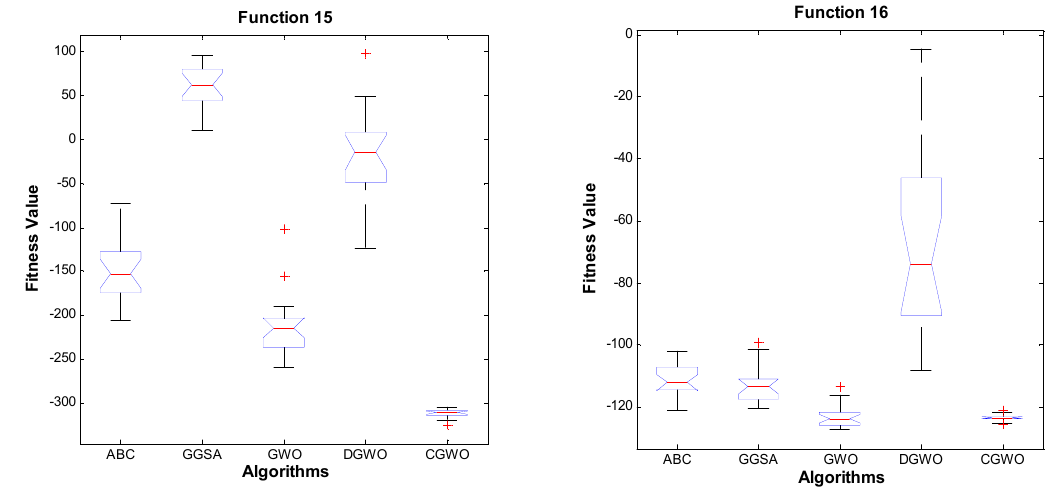
Figure 4. ANOVA tests of ABC, GGSA, GWO, DGWO, and CGWO on multimodal functions with Dim = 30.